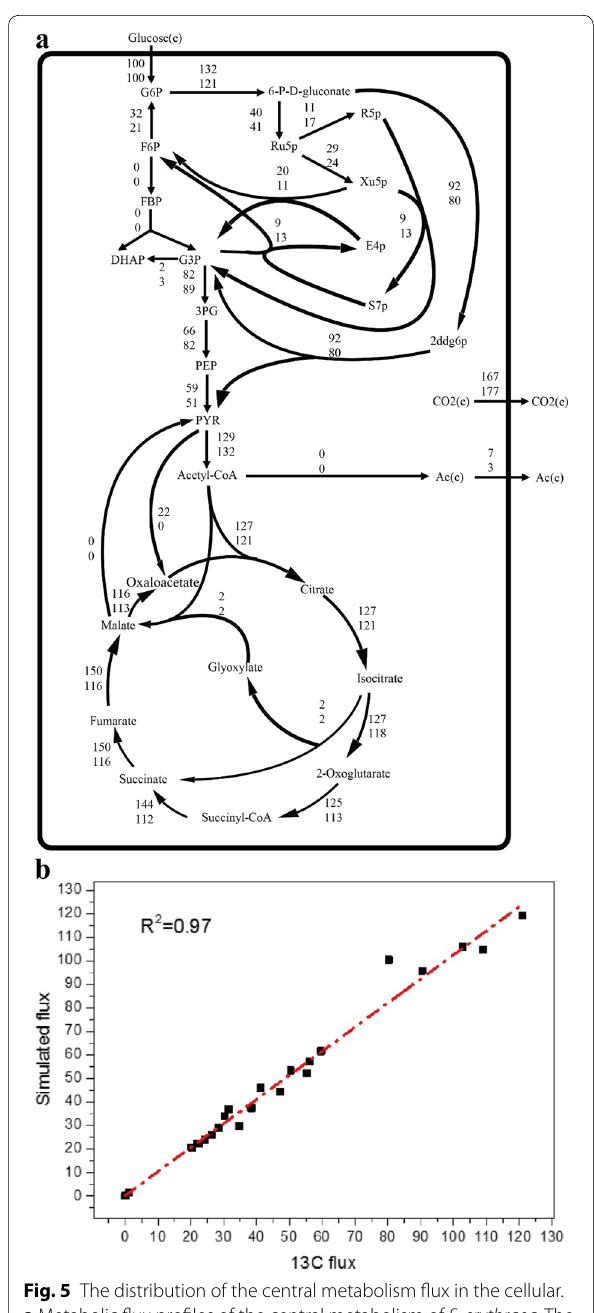
Fig. 5 The distribution of the central metabolism flux in the cellular. a Metabolic flux profiles of the central metabolism of S. erythraea . The upper number represents the flux acquired from the 13 C MFA and the lower number represents the flux simulated from our model